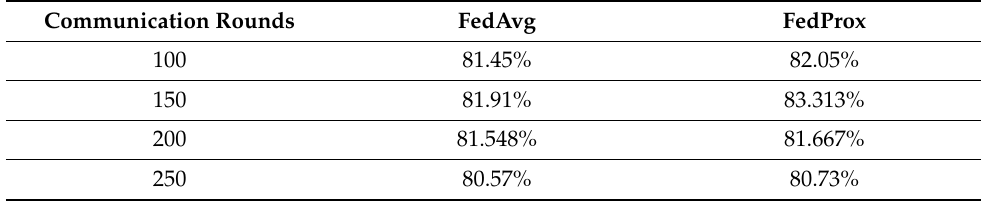
Table 6. Performance comparison of FedAvg and FedProx on test